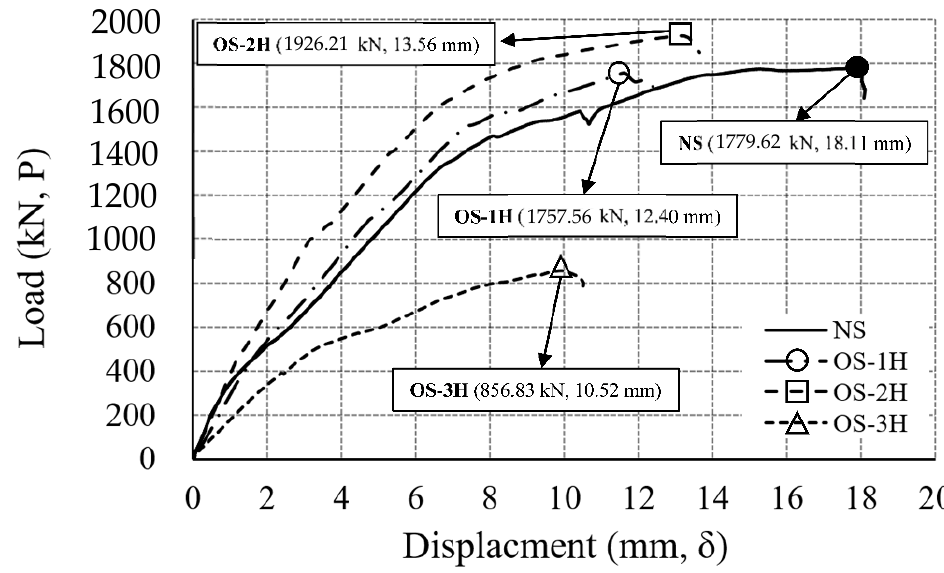
Figure 12. Load–displacement relationship (NS, OS specimen).